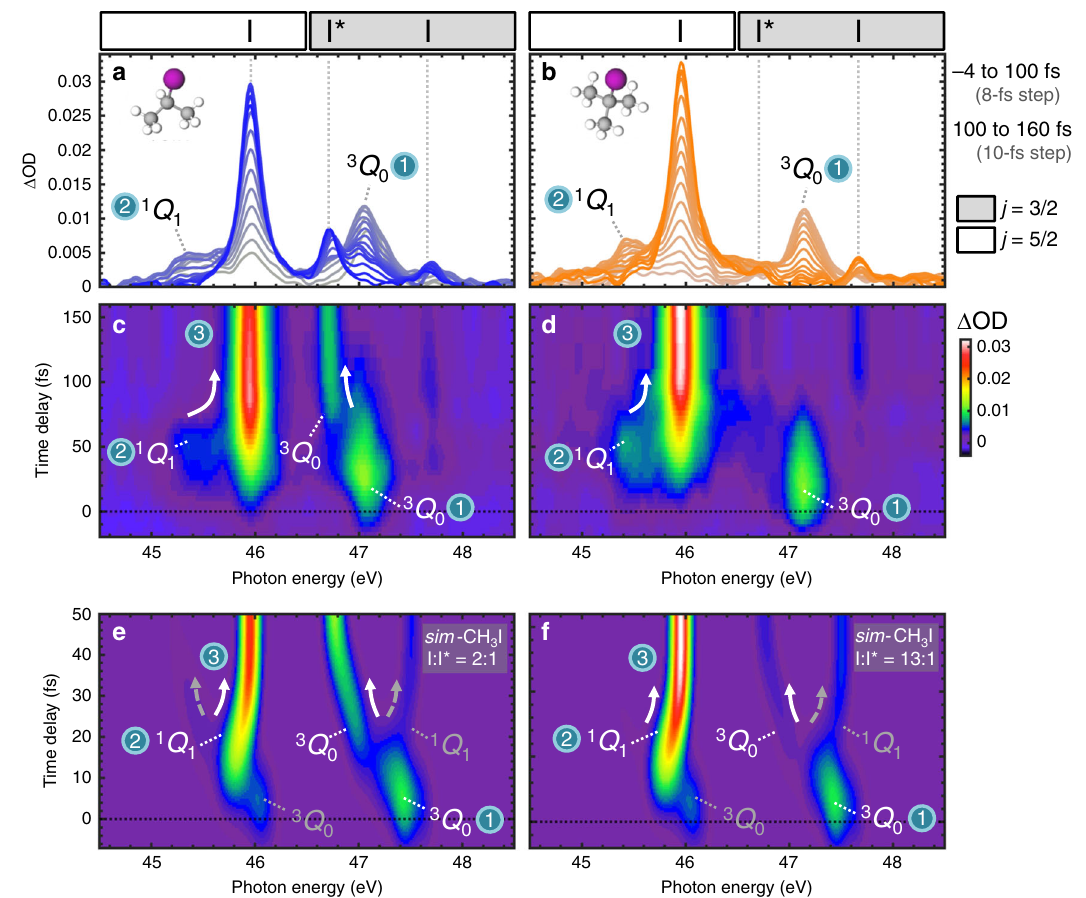
Fig. 2 Experimental i -C 3 H 7 I and t -C 4 H 9 I transients and modi fi ed simulations of CH 3 I transients. Experimental spectra taken at selected time delays between − 4 and 160 fs for a i -C 3 H 7 I and b t -C 4 H 9 I. The spectra are plotted in gray colors that evolve to blue or orange with increasing time delay. Dashed vertical lines indicate the positions of atomic iodine transitions. Regions of the spectra in which (4 d 5/2 ) − 1 and (4 d 3/2 ) − 1 core-level transitions appear are demarcated by white and gray boxes, respectively. Adjacent I(45.9 eV) and 3 Q 0 (47.1eV) peaks overlap slightly in the 46.4 – 46.8 eV region. Experimental transients for c i -C 3 H 7 I and d t -C 4 H 9 I plotted as colormaps. State-speci fi c molecular features and their convergence (indicated by arrows) to the atomic transitions are labeled according to the Region 1 – 3 labeling scheme introduced in Fig. 1a. Modi fi ed transient simulations of CH 3 I converging to the empirical I:I* branching ratios of e i -C 3 H 7 I and f t -C 4 H 9 I. The simulations are temporally broadened by a Gaussian and independently normalized for comparison to the (Fig. 2a – d), discrete molecular features located at 47.1 and 45.4 eV are transiently observed. While the two features both rise and decay within 100 fs, they otherwise exhibit different dynamics. The 47.1 eV feature is observed to maximize in 45.4 eV feature maximizes in intensity 25 fs later, and its rise thus two features converge to different atomic absorption lines in the